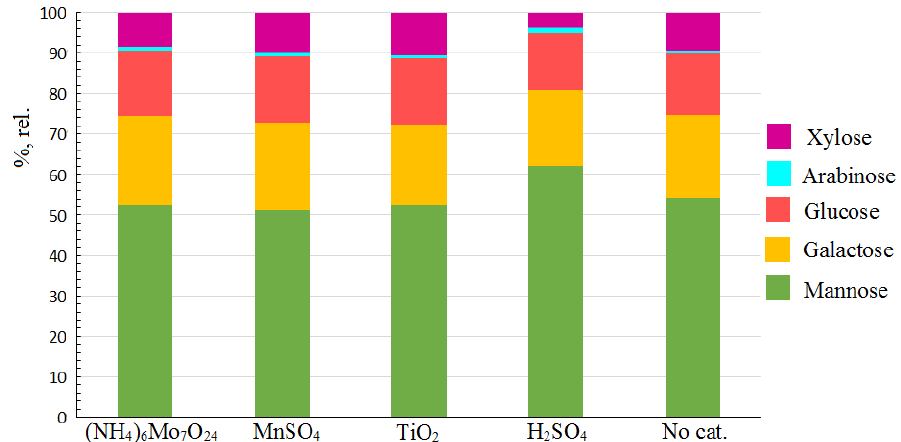
Figure 1. Monosaccharide composition of the hemicelluloses isolated from liquid products of oxidative delignification of spruce wood with different catalysts and without them (percentage of the total monosaccharide content).